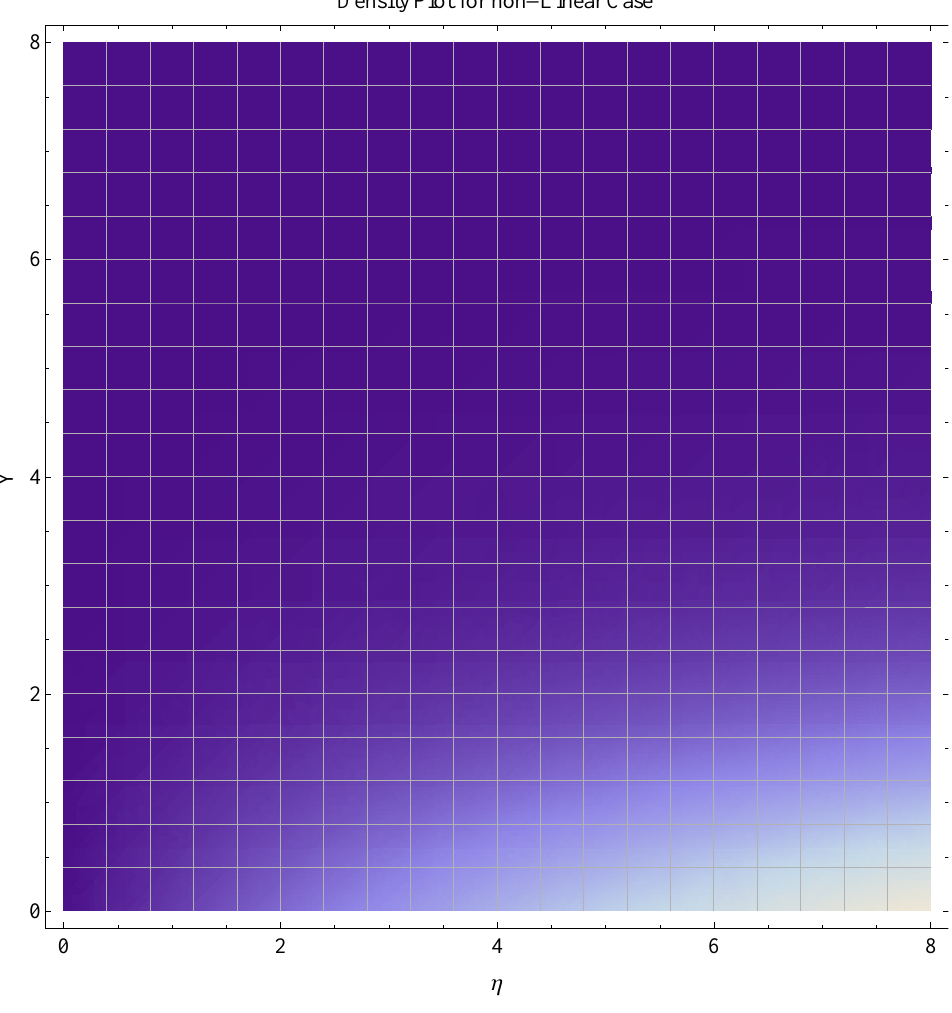
Figure 16. Density graph for nonlinear case. Table 1. Numerical data obtained for skin friction setting n =